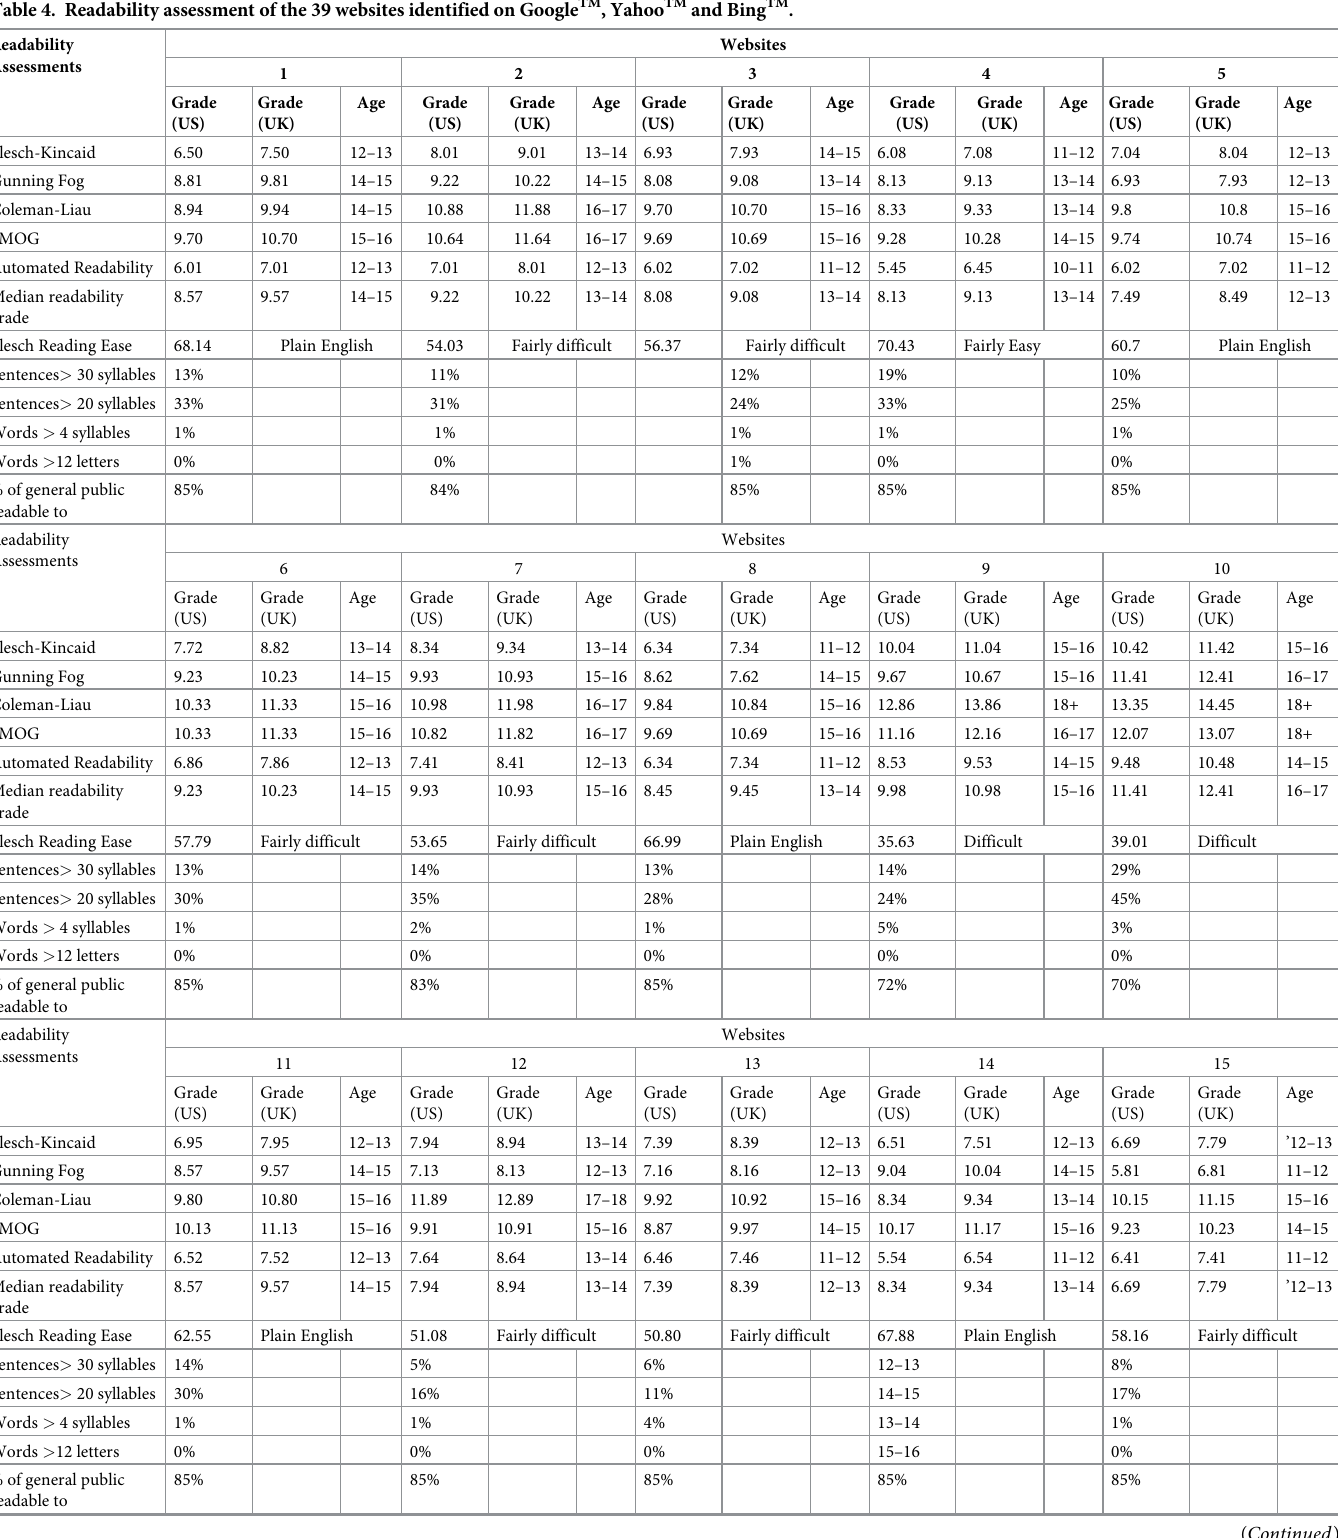
Table 4. Readability assessment of the 39 websites identified on Google TM , Yahoo TM and Bing TM